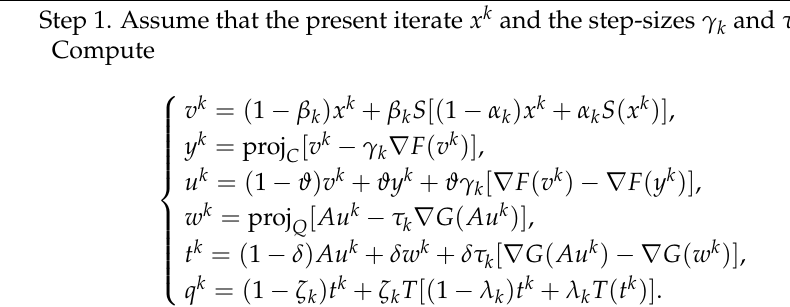
Algorithm 3: Select an initial point x 0 ∈ C . Set k =